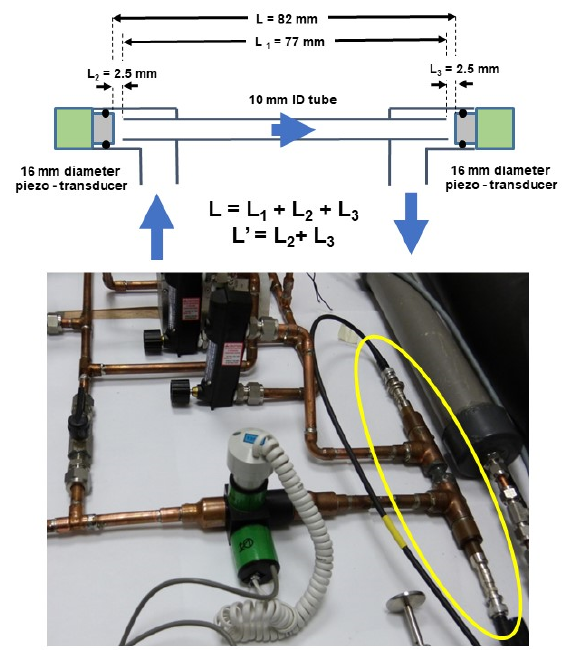
Figure 4. Geometry of a prototype flowmeter and gas analyzer for xenon-oxygen anesthetic gas mixtures.